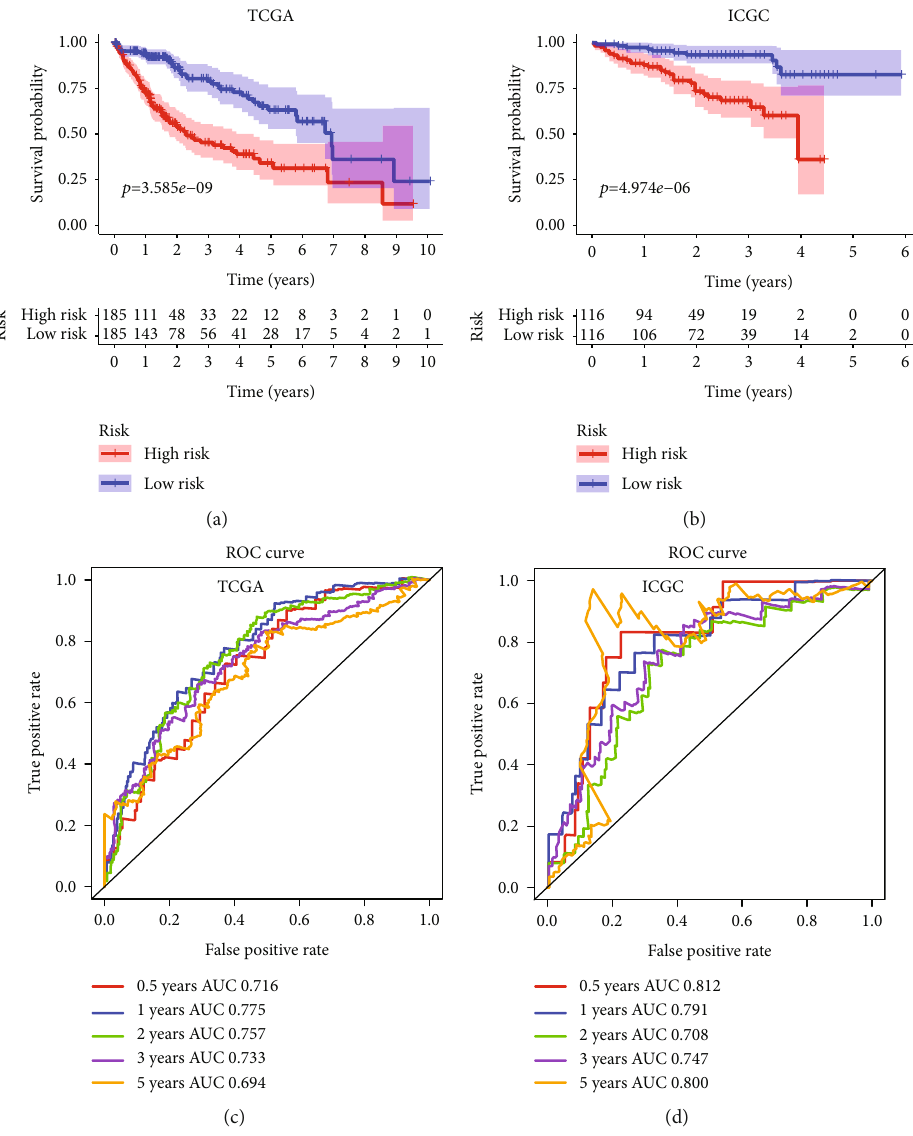
Figure 3: Survival analysis with the three-gene signature in the training and validation datasets. (a and b) Kaplan-Meier overall survival analysis of HCC patients in the TCGA (a) and ICGC (b) datasets assigned to high-and low-risk groups based on the risk score. Patients with a higher risk score exhibited poorer overall survival in the training and validation cohorts. (c and d) ROC curves showed the predictive e ffi ciency of the risk signature for HCC patients in the TCGA (c) and ICGC (d) datasets on the survival